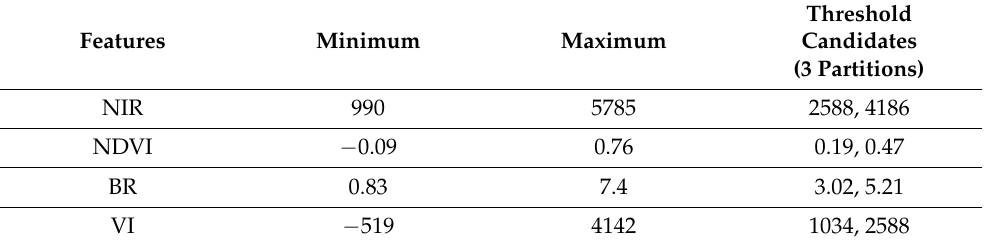
Table 4. Important features and their threshold candidates.